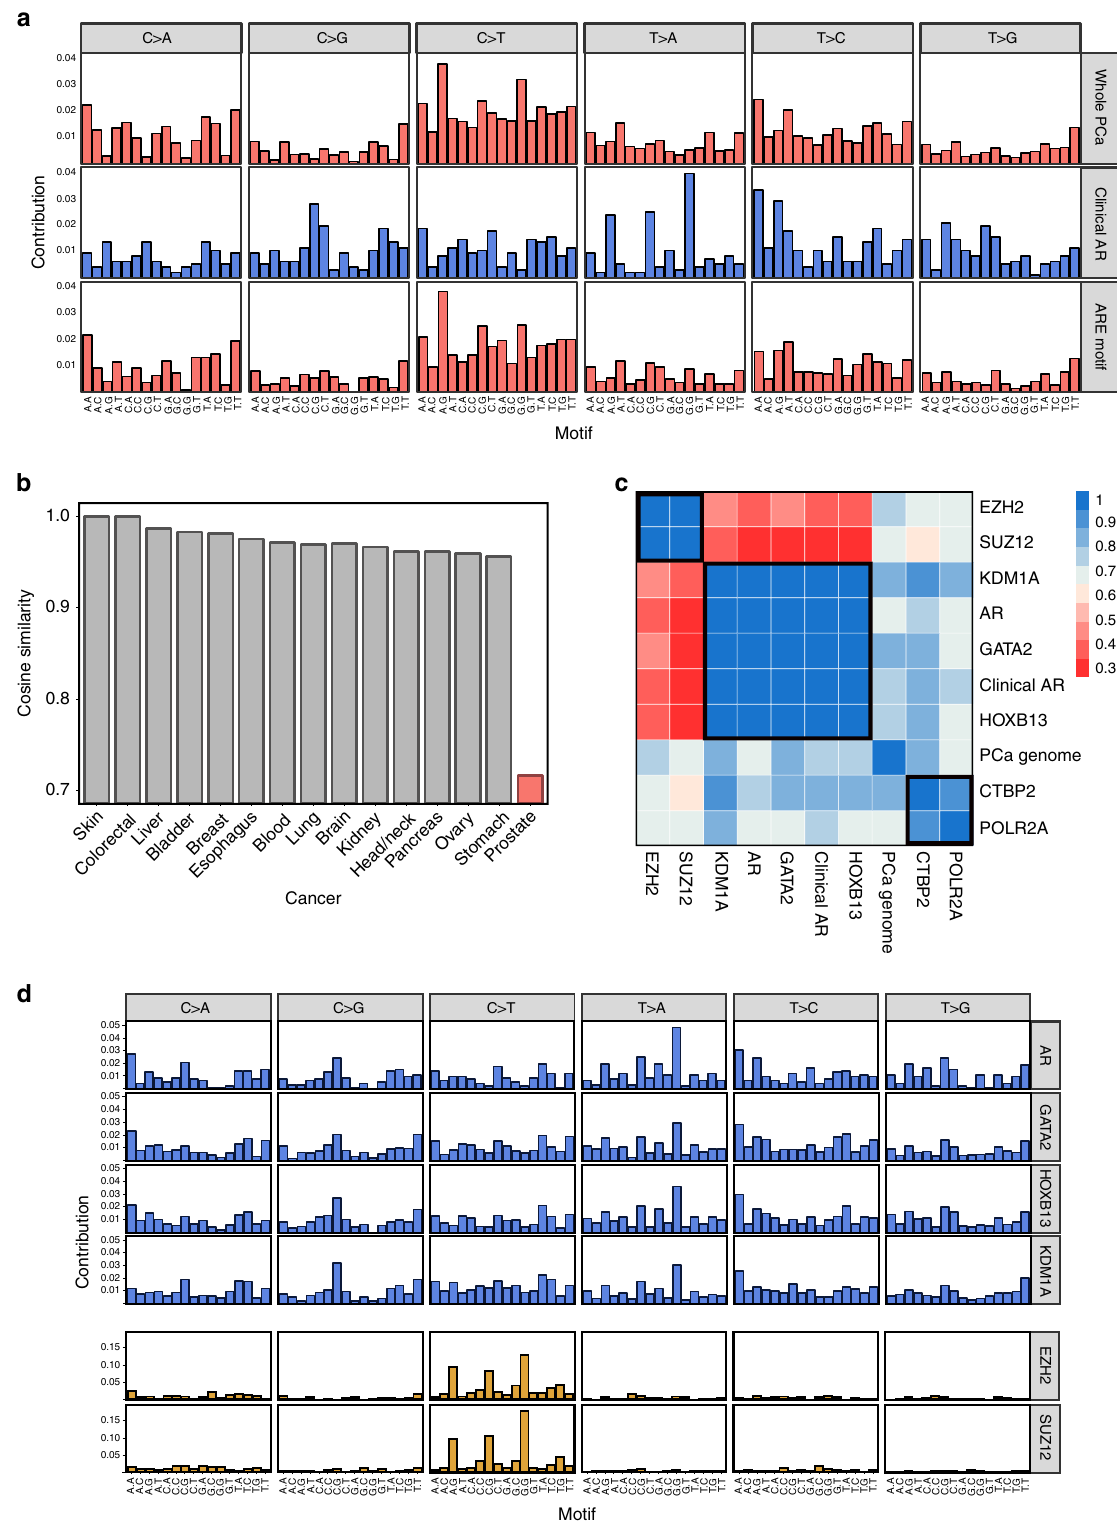
Fig. 3 ARBS have a different mutation signature. a The type of mutations at clinical ARBS were compared with all those found in the whole PCa genome or those regions that contain an ARE motif but no AR. b The mutational signature at ARBS chromosomal regions was compared with the remainder of the genome in multiple cancer types. Only PCa was found to have an altered mutational signature at ARBS. c The mutational signature of each TFs-binding site was compared and three clusters of mutation types were observed at SUZ12/EZH2 [group 1], KDM1A/AR/GATA2/HOXB13 [group 2] and CTBP2/ POLR2A [group 3] d . Detailed analysis of the group 1 and group 2 are